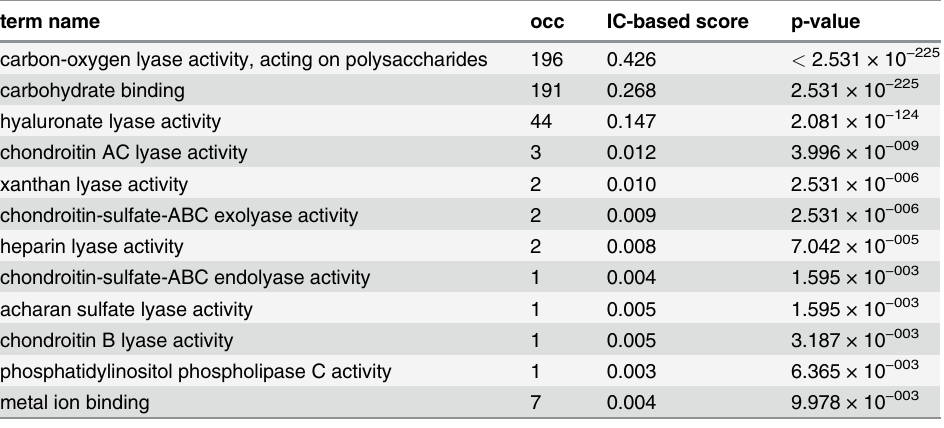
Table 2. Term annotated occurrence (occ) number, IC-based term score and enrichment p-values for the PL8 Set signi fi cant terms (alpha = 0.01) while using the complete CAZy Collection as